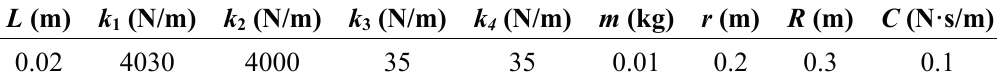
Figure 3. Comparison of the natural frequencies of two NSEHs (from Tables 1 and 2) at various wheel speeds. Table 1. Design parameters of the analytical model for high wheel speeds.